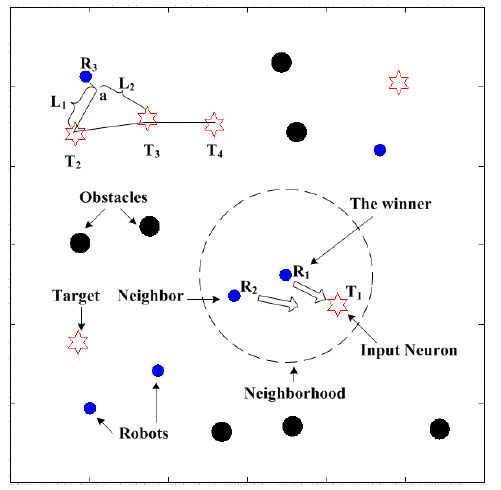
Figure 2. The process of the SOM with the locking mechanism.